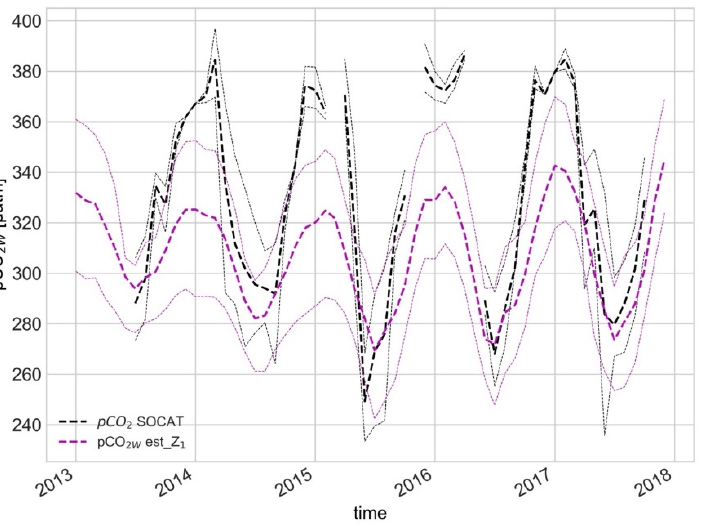
Figure 4. Monthly mean of pCO 2W from SOCAT (black) and estimated using the Z 1 model (magenta) in the European Arctic Sector with errors.